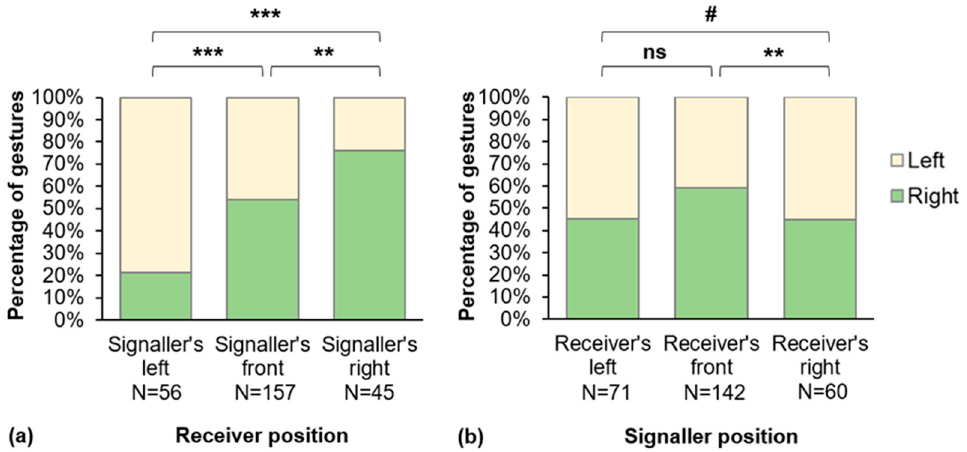
Figure 2. ( a ) Percentage of gestures produced with the left or right hand, depending on the receiver position in the signaler’s visual field; ( b ) Percentage of gestures produced with the left or right hand, depending on the signaler position in the receiver’s visual field. GLMM Binomial: ns: non-significant difference; #: 0.05 < p < 0.1; **: p < 0.01; ***: p <